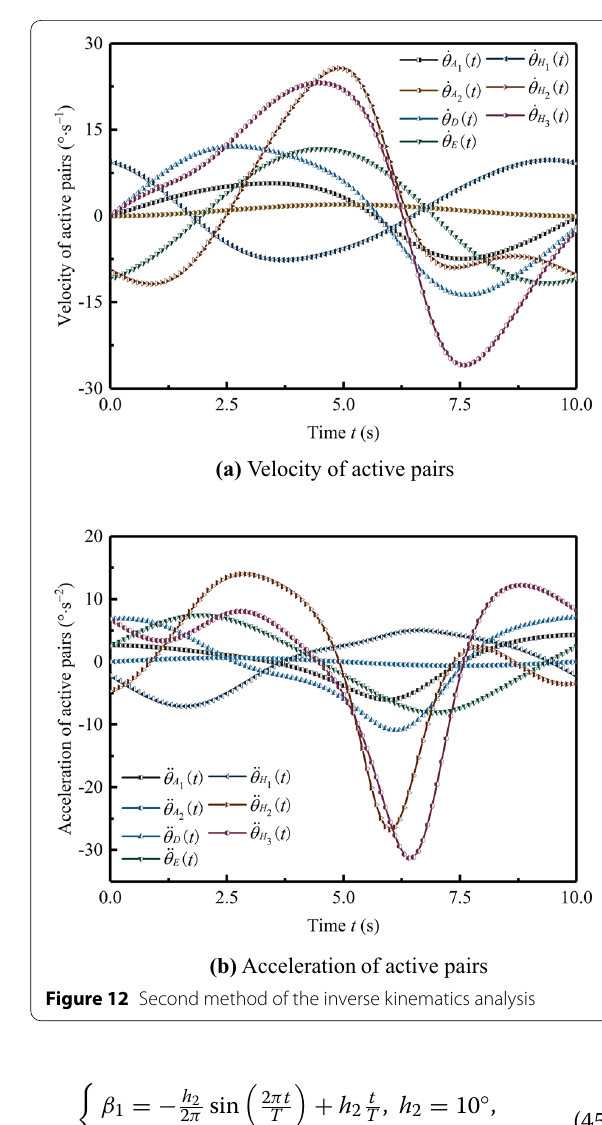
Figure 12 Second method of the inverse kinematics